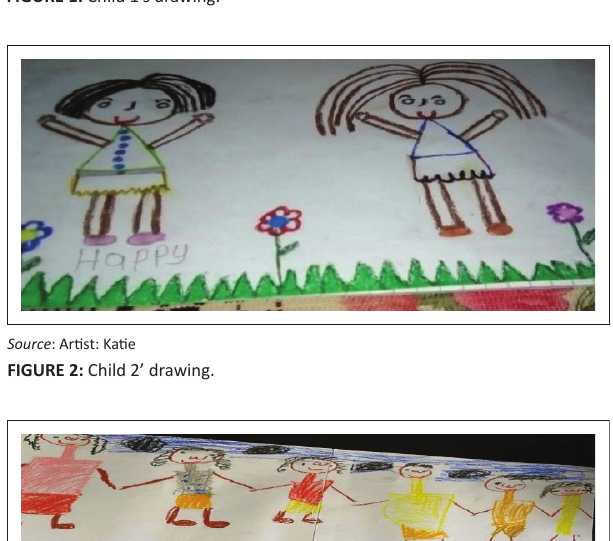
FIGURE 1: Child 1’s drawing.